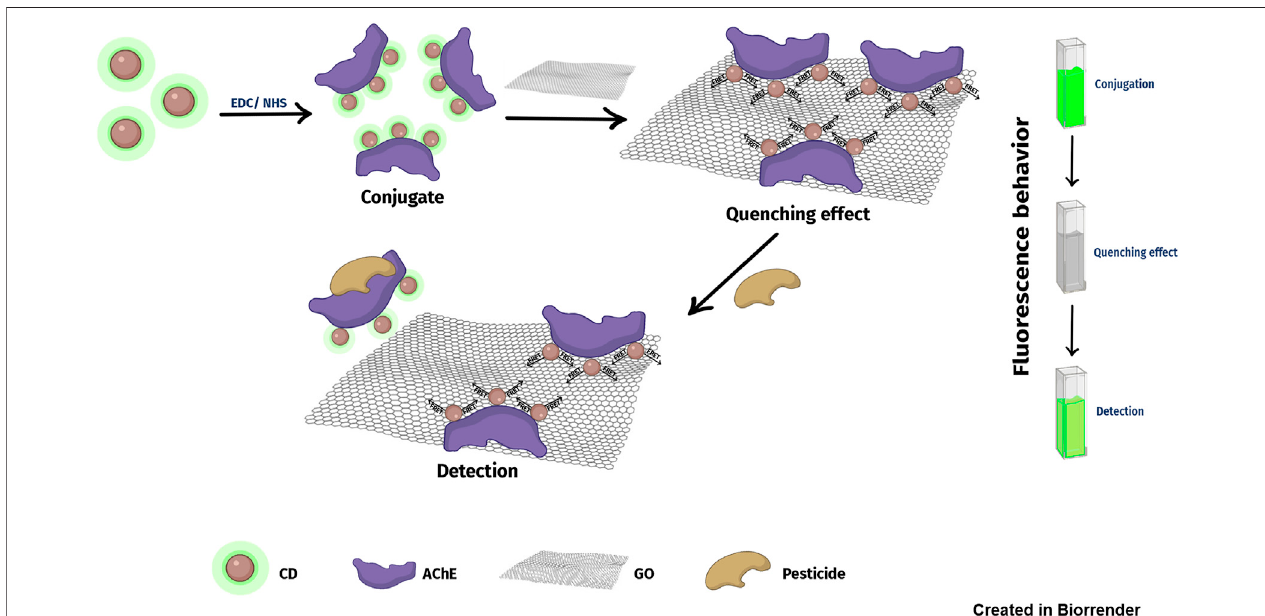
FIGURE 5 | The detection mechanism of the proposed biosensor showing the quenching of the fl uorescence for the CD conjugated with AChE in the presence of GO, and the recovery of the fl uorescence signal in the presence of the pesticide.